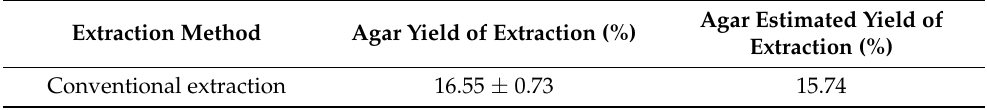
Table 5. Agar yield obtained from the optimized conventional extraction ( n =